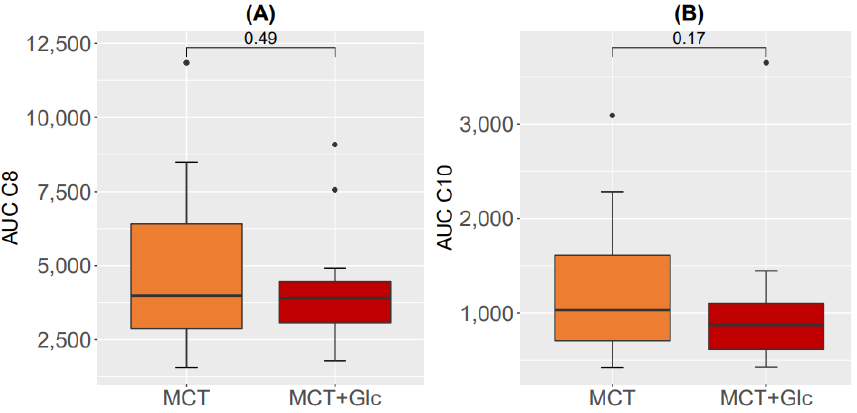
Figure 7 . Differences in AUCs (µg/mL * h/L) for plasma MCFA: ( A ) plasma octanoate after MCT oil alone and after MCT oil plus glucose; ( B ) plasma decanoate after MCT oil alone and MCT oil plus glucose. A linear regression analysis between plasma BHB and plasma C8 and C10 is pre- sented in Figure 8A,B. Linear regression analysis with plasma C8 showed a significant increase in plasma BHB levels with MCT (slope = 7.587, t = 7.040, p < 0.001) and a signifi- cantly greater increase with MCT plus glucose (slope = 15.594, t = 10.698, p < 0.001).